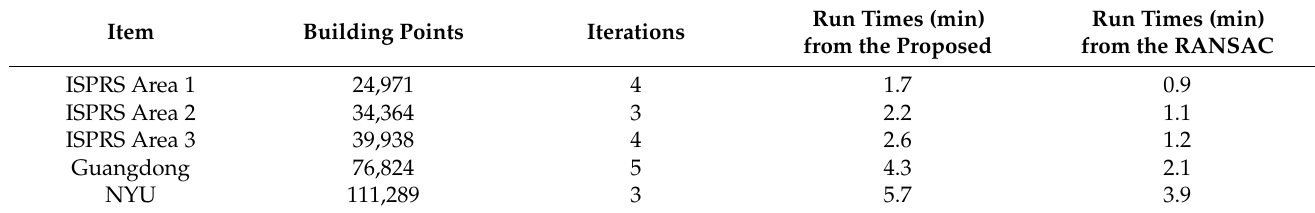
Table 2. Statistics of experiments on energy optimization.